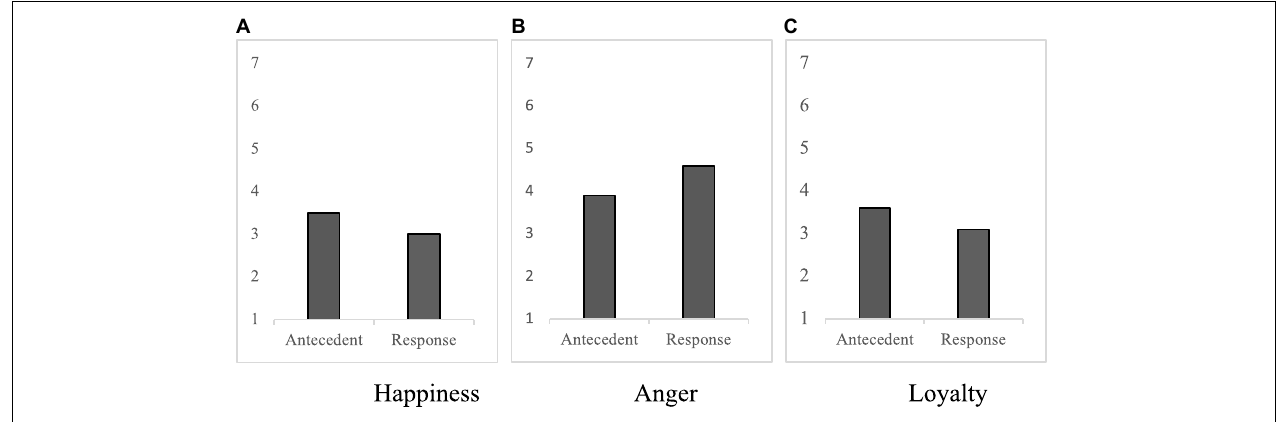
FIGURE 1 | Means for happiness (A) , anger (B) , and brand loyalty (C) in Study 1.